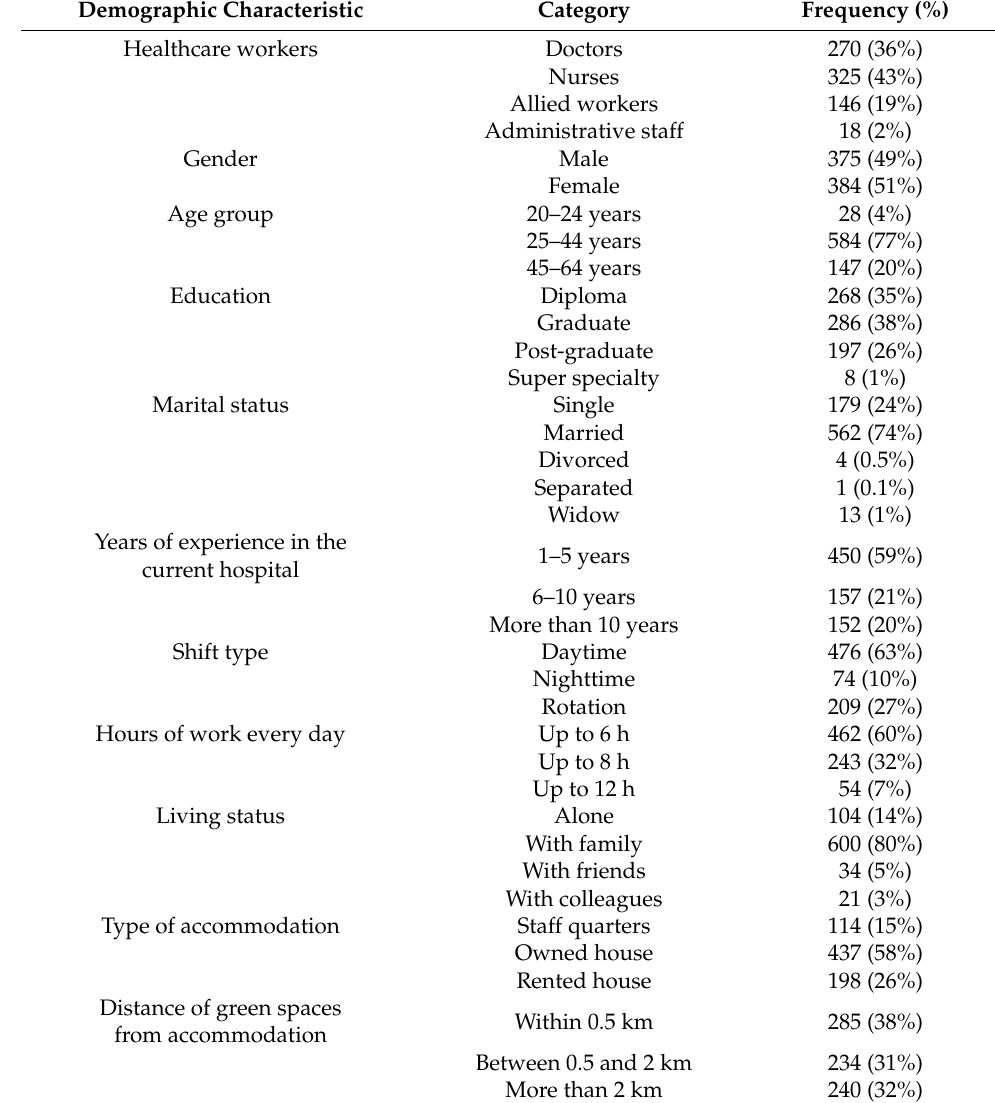
Table 1. Participant demographic